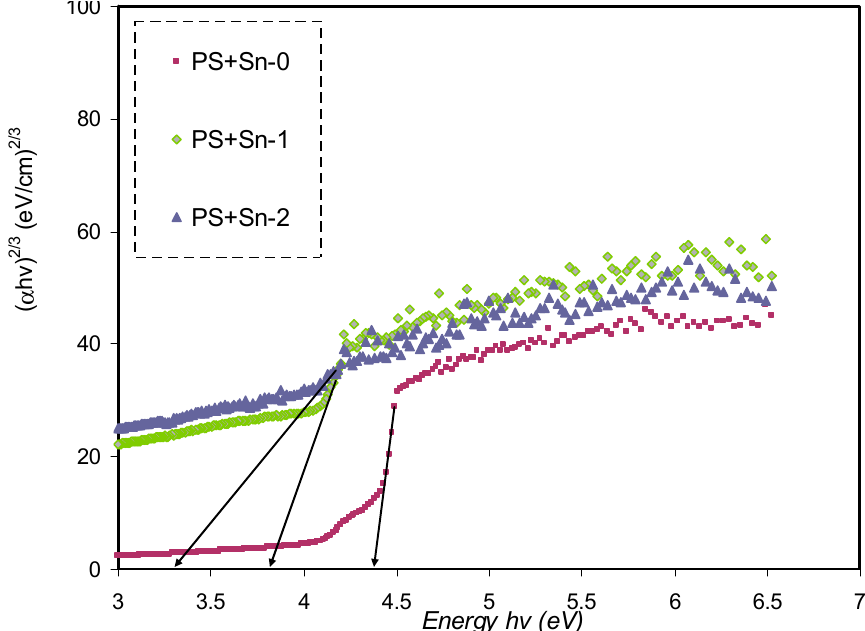
Figure 11. Plot of ( α h υ ) 2 / 3 versus photon energy for pure PS (PSSNT0), PSSNT1, and PSSNT2 NC films.